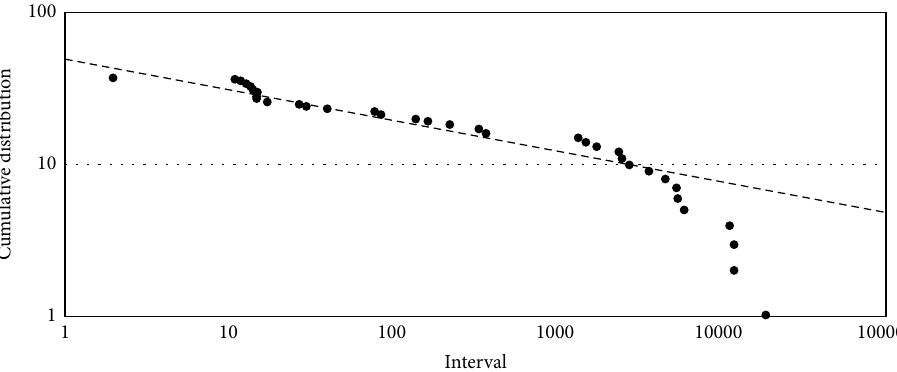
Figure 4: Cumulative distribution of the intervals between severe jams for the multi-state NS model, showing data for 100,000 time steps. Here, the vehicle density is 0.40, 𝑝 = 0.01 , v max = 5 , threshold_slow = 5, and threshold_acceleration = 15.